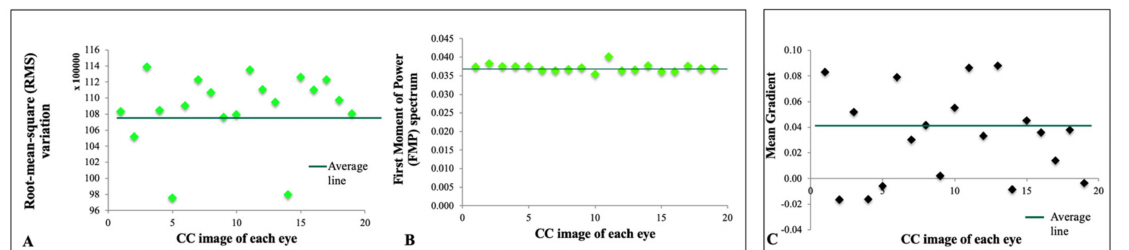
Figure 4. Fourier transform analysis of parameters. Root mean square (RMS) variation ( A ) and First Moment of Power (FMP) spectrum ( B ) is shown. Edge frequency analysis ( C ) is